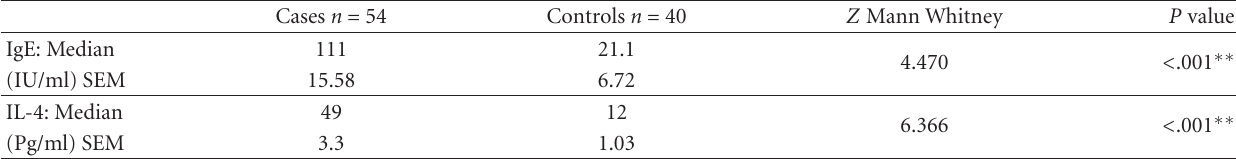
Table 1: Comparison of IgE and IL-4 levels between cases and controls using Mann-Whitney test.